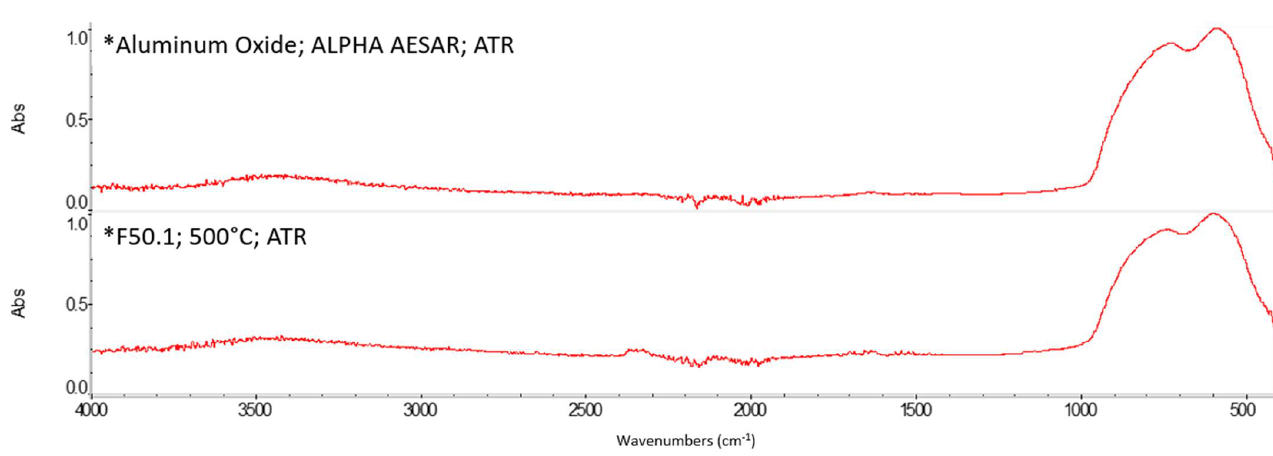
Figure A8. FTIR spectra. Al 2 O 3 versus ashes of F50.1 at 500 °C.